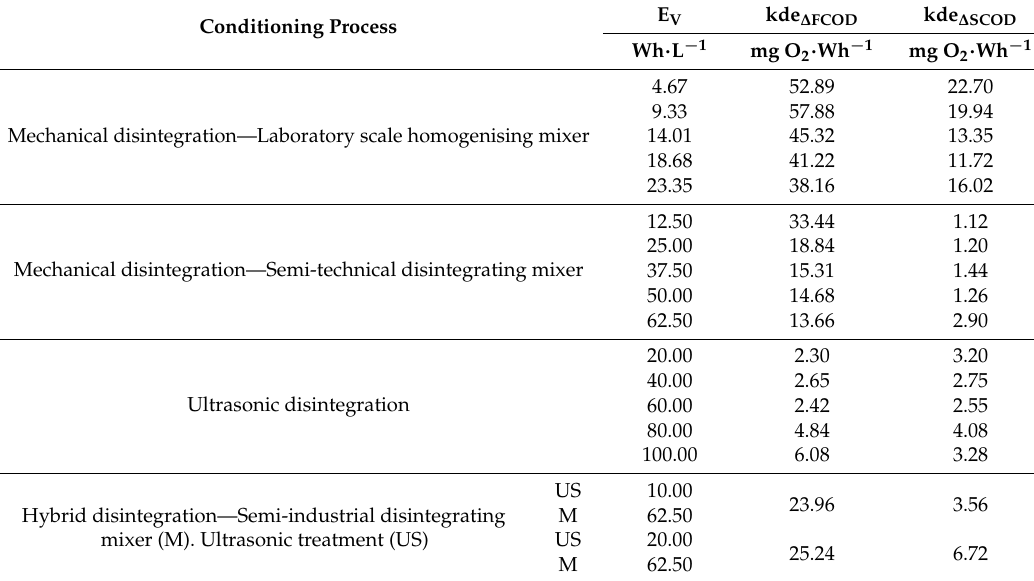
Table 7. Changes in the efficiency of obtaining disintegration products ( ∆ COD and ∆ SCOD mg O 2 · L − 1 per 1 Wh) with different conditioning